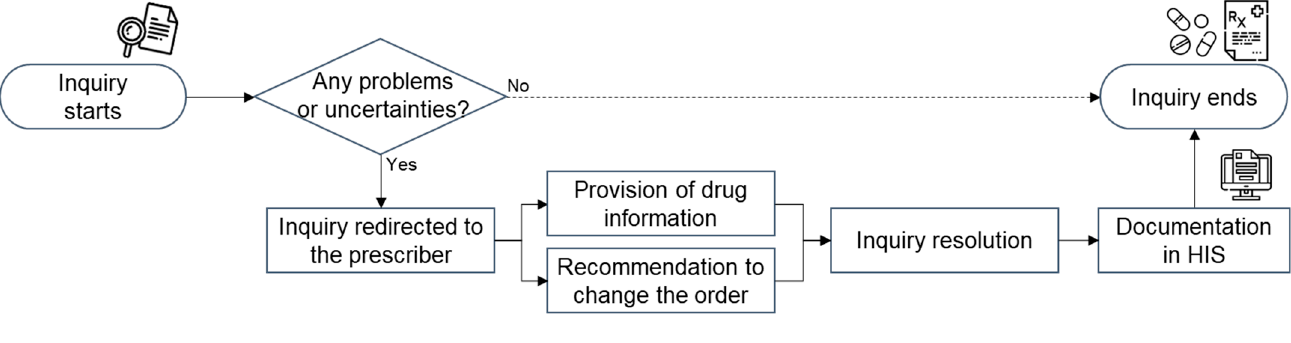
Figure 1. The inquiry process during order review in the pharmacy department (icons made by Freepik [https://www.freepik.com, accessed on 15 July 2022] from www.flaticon.com, accessed on 15 July 2022). HIS: health information system.